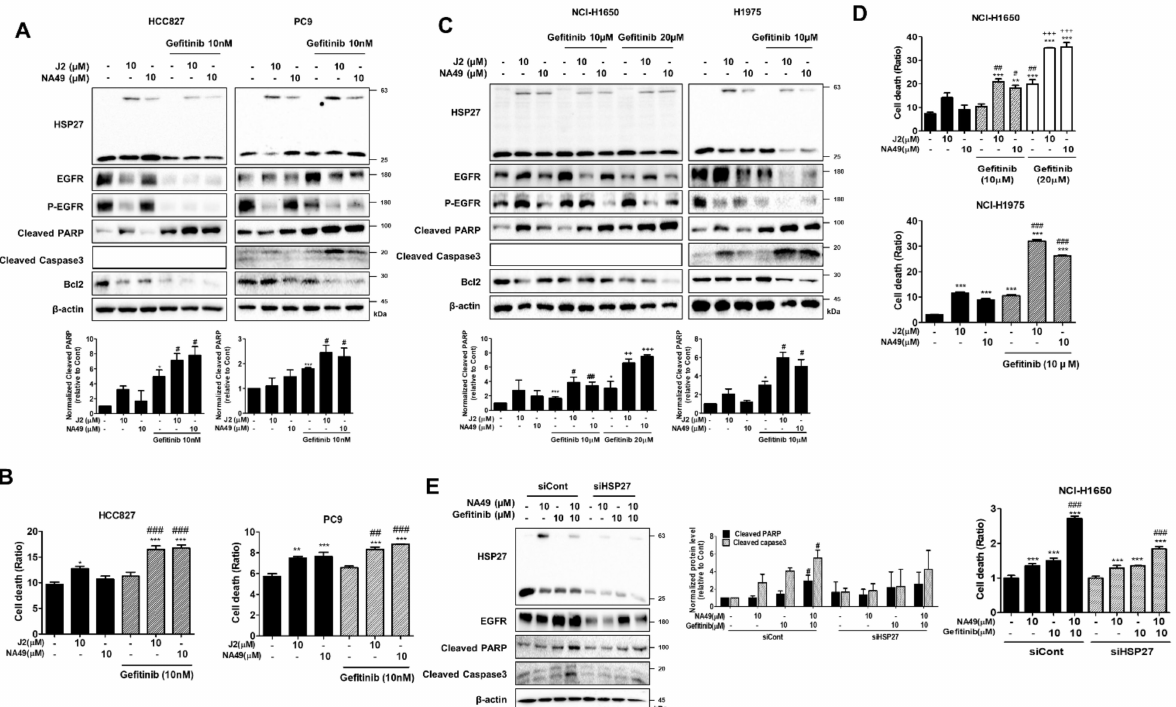
Figure 6. J2 and NA49 showed sensitization effects on EGFR mutant-type lung cancer cells in combination with gefitinib. ( A ) HCC827 and PC9 cells were treated with J2 (10 µ M) and NA49 (10 µ M) for 24 h, with or without gefitinib (10 nM), and cell lysates were detected by Western blot analysis. Protein levels were quantified using Image J software. The data were expressed as the fold change relative to the control and normalized to β -actin in the graph. ( B ) Cell death was analyzed by flow cytometry after propidium iodide (PI) staining. Results are the mean and standard deviation of three independent experiments (* p < 0.05, ** p < 0.01, *** p < 0.001 vs. untreated-control; # p < 0.05, ## p < 0.01, ### p < 0.001 vs. gefitinib alone). ( C ) NCI-H1650 cells were treated with J2 (10 µ M) or NA49 (10 µ M) for 24 h, with or without gefitinib (10 or 20 µ M) and NCI-H1975 cells were treated with J2 (10 µ M) or NA49 (10 µ M) for 24 h, with or without gefitinib (10 µ M), and cell lysates were detected by Western blot. Protein levels were quantified using Image J software. The data were expressed as the fold change relative to the control and normalized to β -actin in the graph. ( D ) Cell death was analyzed by flow cytometry after propidium iodide (PI) staining. Results are the mean and standard deviation of three independent experiments (* p < 0.05, ** p < 0.01, *** p < 0.001 vs. untreated-control; # p < 0.05, ## p < 0.01, ### p < 0.001 vs. gefitinib alone 10 µ M; + p < 0.05, ++ p < 0.01, +++ p < 0.001 vs. gefitinib alone 20 µ M). ( E ) NCI-H1650 cells transfected with control (siCont) or siRNA of HSP27 (siHSP27) were treated with NA49 (10 µ M) with or without gefitinib (10 µ M), cell lysates were detected by Western blot analysis, and cell death was analyzed by flow cytometry after propidium iodide (PI) staining. Protein levels were quantified using Image J software. The data were expressed as the fold change relative to the control and normalized to β -actin in the graph. Results are the mean and standard deviation of three independent experiments (* p < 0.05, ** p < 0.01, *** p < 0.001 vs. untreated-control; # p < 0.05, ## p < 0.01, ### p < 0.001 vs. gefitinib